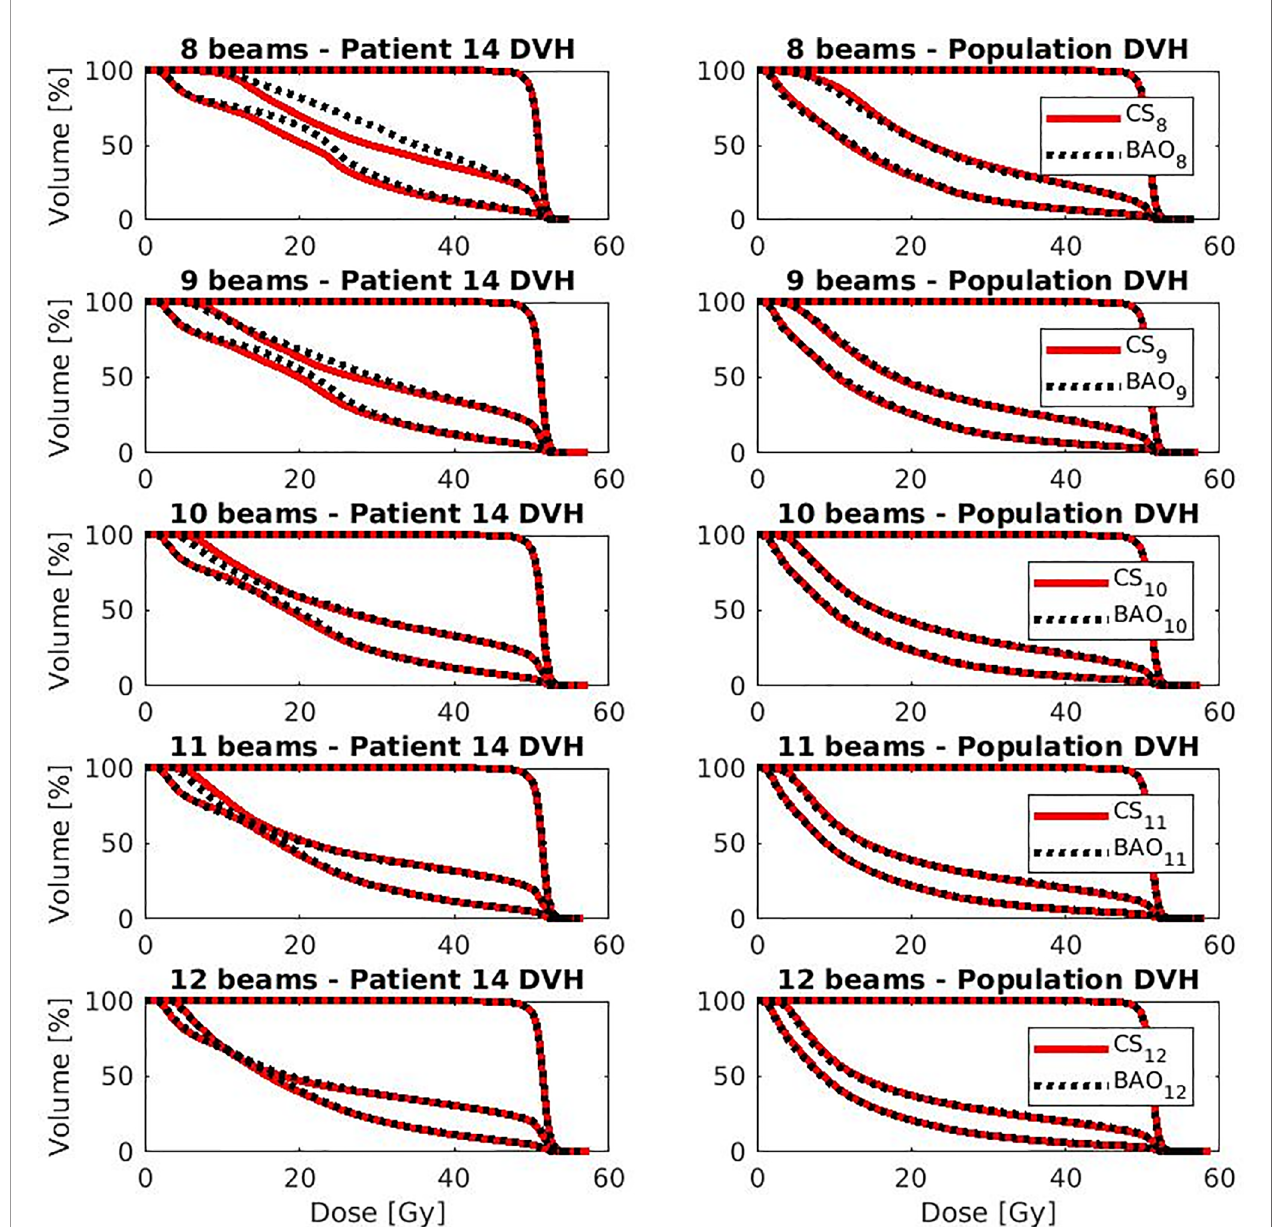
FIGURE 4 | OAR and PTV DVHs for the patient with largest difference (i.e., patient 14 from Figure 4) (left column) and population average DVH (right column) for x=8-12. Leave-one-out data was used for CS x .